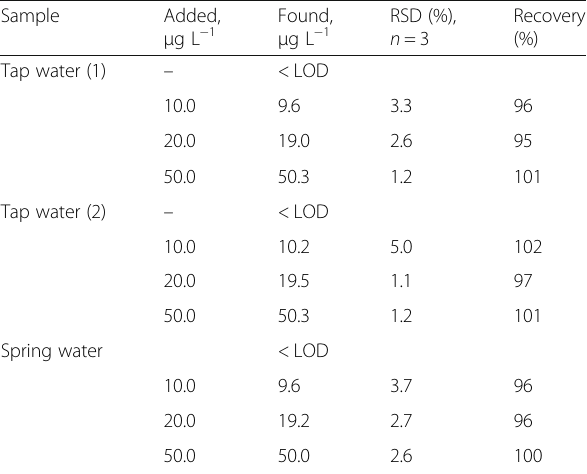
Table 5 Determination of copper in water samples